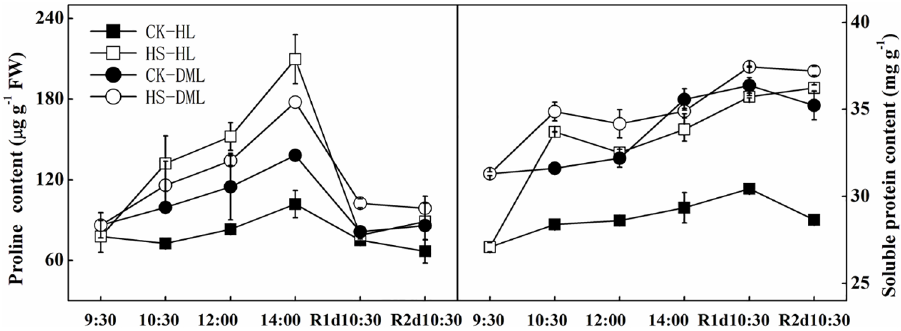
Fig 6. Effects of heat shock and recovery on the proline content and the soluble protein content in leaves of healthy and downy mildew-infected cucumber. The data represent the mean ± SE (n = 5).